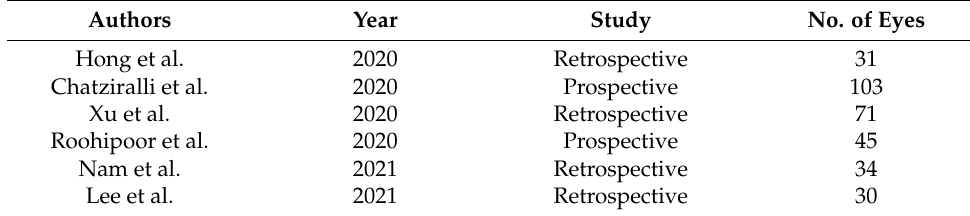
Table 2. OCT angiography.